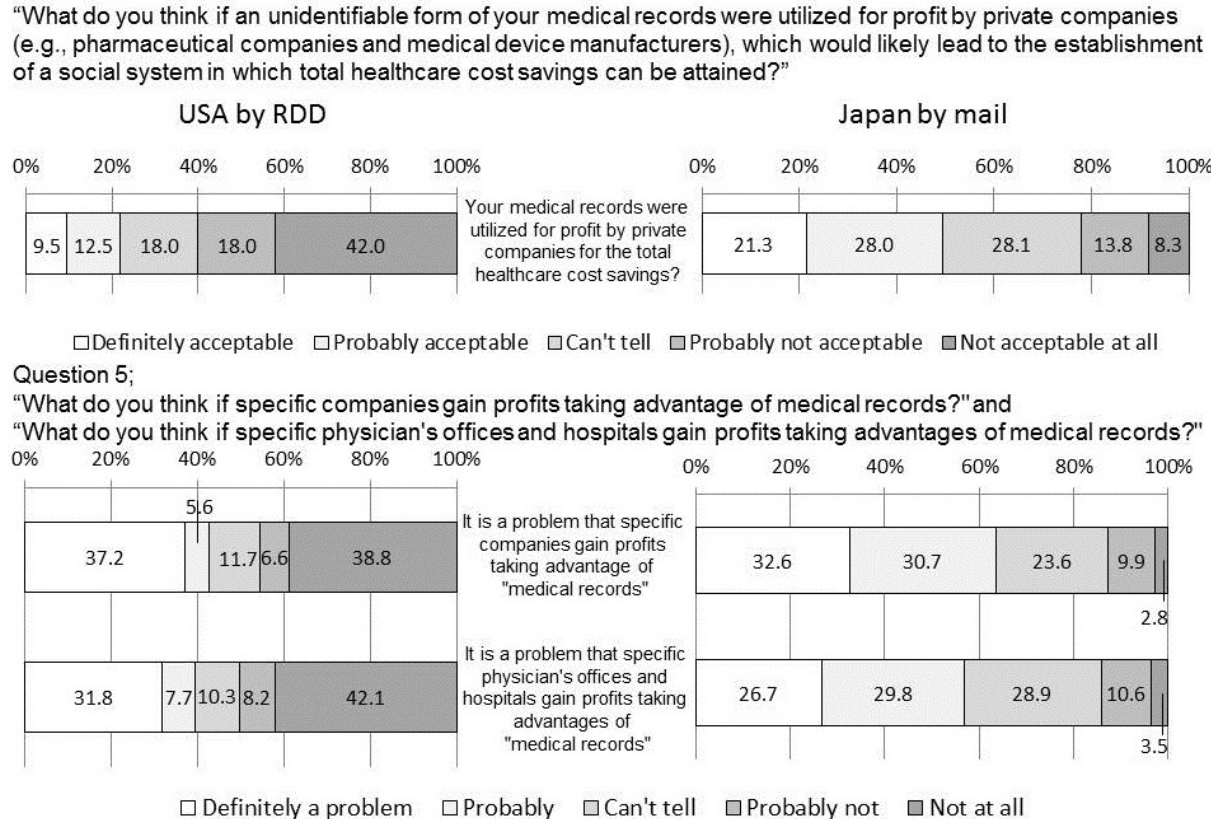
Figure 3. Findings related to secondary usage of information.